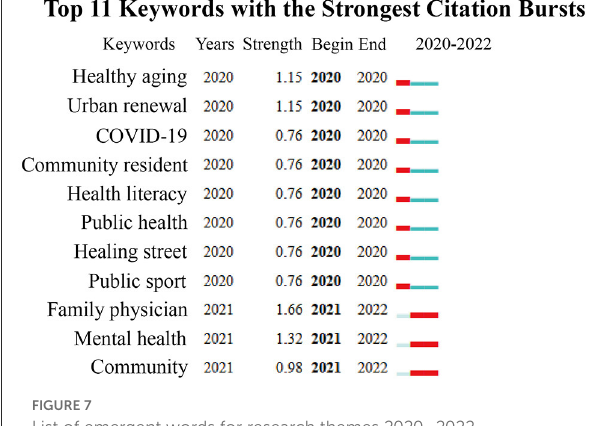
FIGURE7 List of emergent words for research themes